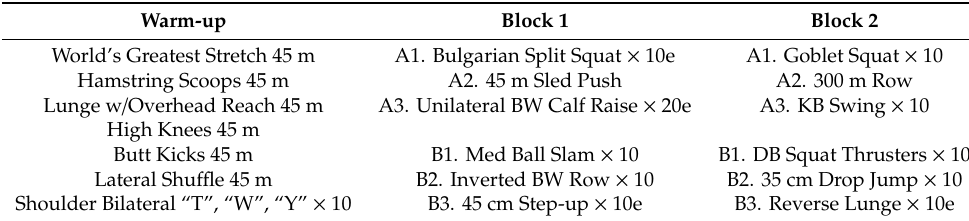
Table 2. Warm-up and cross-training